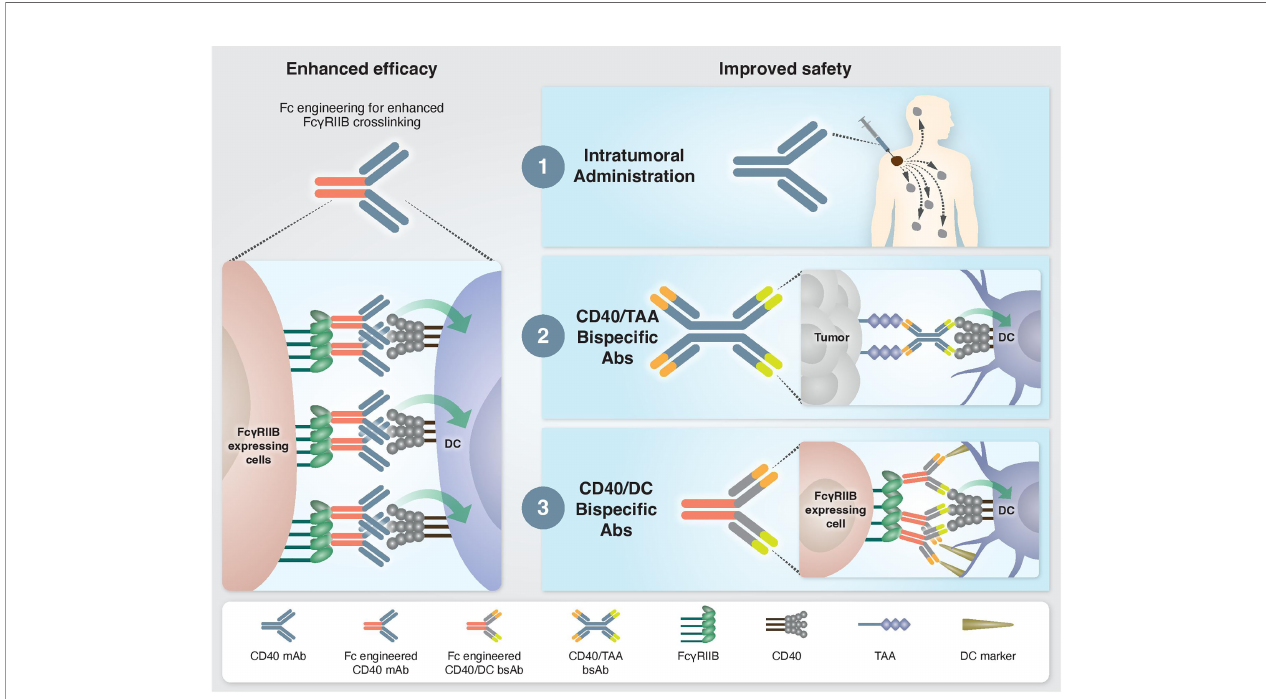
FIGURE 1 | Approaches to enhance the ef fi cacy and safety of CD40 agonistic mAbs. Left: Enhanced CD40 agonism by Fc-engineered mAbs designed to increase Fc g RIIB-mediated crosslinking. Right: Approaches to bypass treatment associated toxicities. 1) Intratumoral administration. Injection of low mAb dose directly into the tumor enables local antitumor immune activation without systemic side effects. 2) Tumor-targeted bispeci fi c CD40 antibodies direct the agonistic antibody to the TME by targeting tumor-associated antigens, which are overexpressed and/or selectively expressed at the tumor site. 3) Dendritic cell-targeted bispeci fi c CD40 antibodies direct the agonistic antibody to the cell types that drive treatment-associated antitumor activity but not